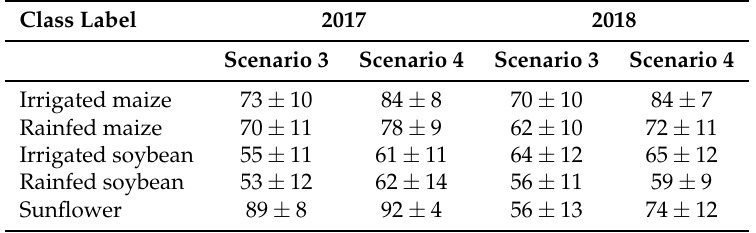
Table 7. Average confidence for the years 2017 and 2018, with associated standard deviations, expressed in